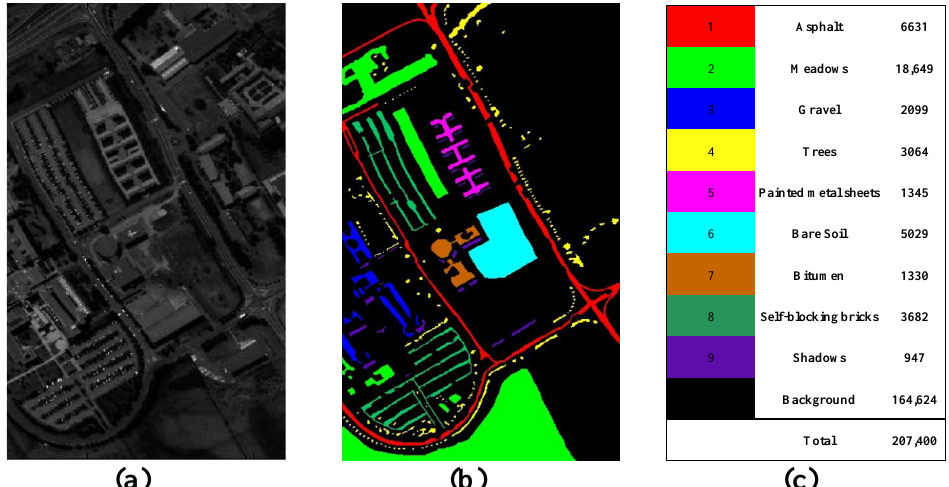
Figure 8. Pavia University imagery: ( a ) color composite with RGB, ( b ) ground truth, and ( c ) class names with available samples.